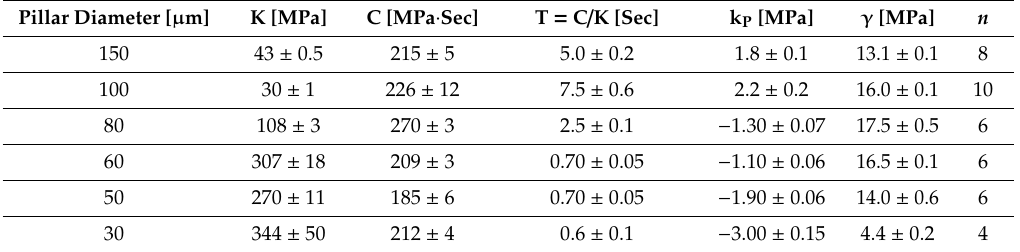
Table 1. Model parameters for foam-like behavior of pristine vertically-aligned multi-walled carbon nanotube (VA-MWCNT)